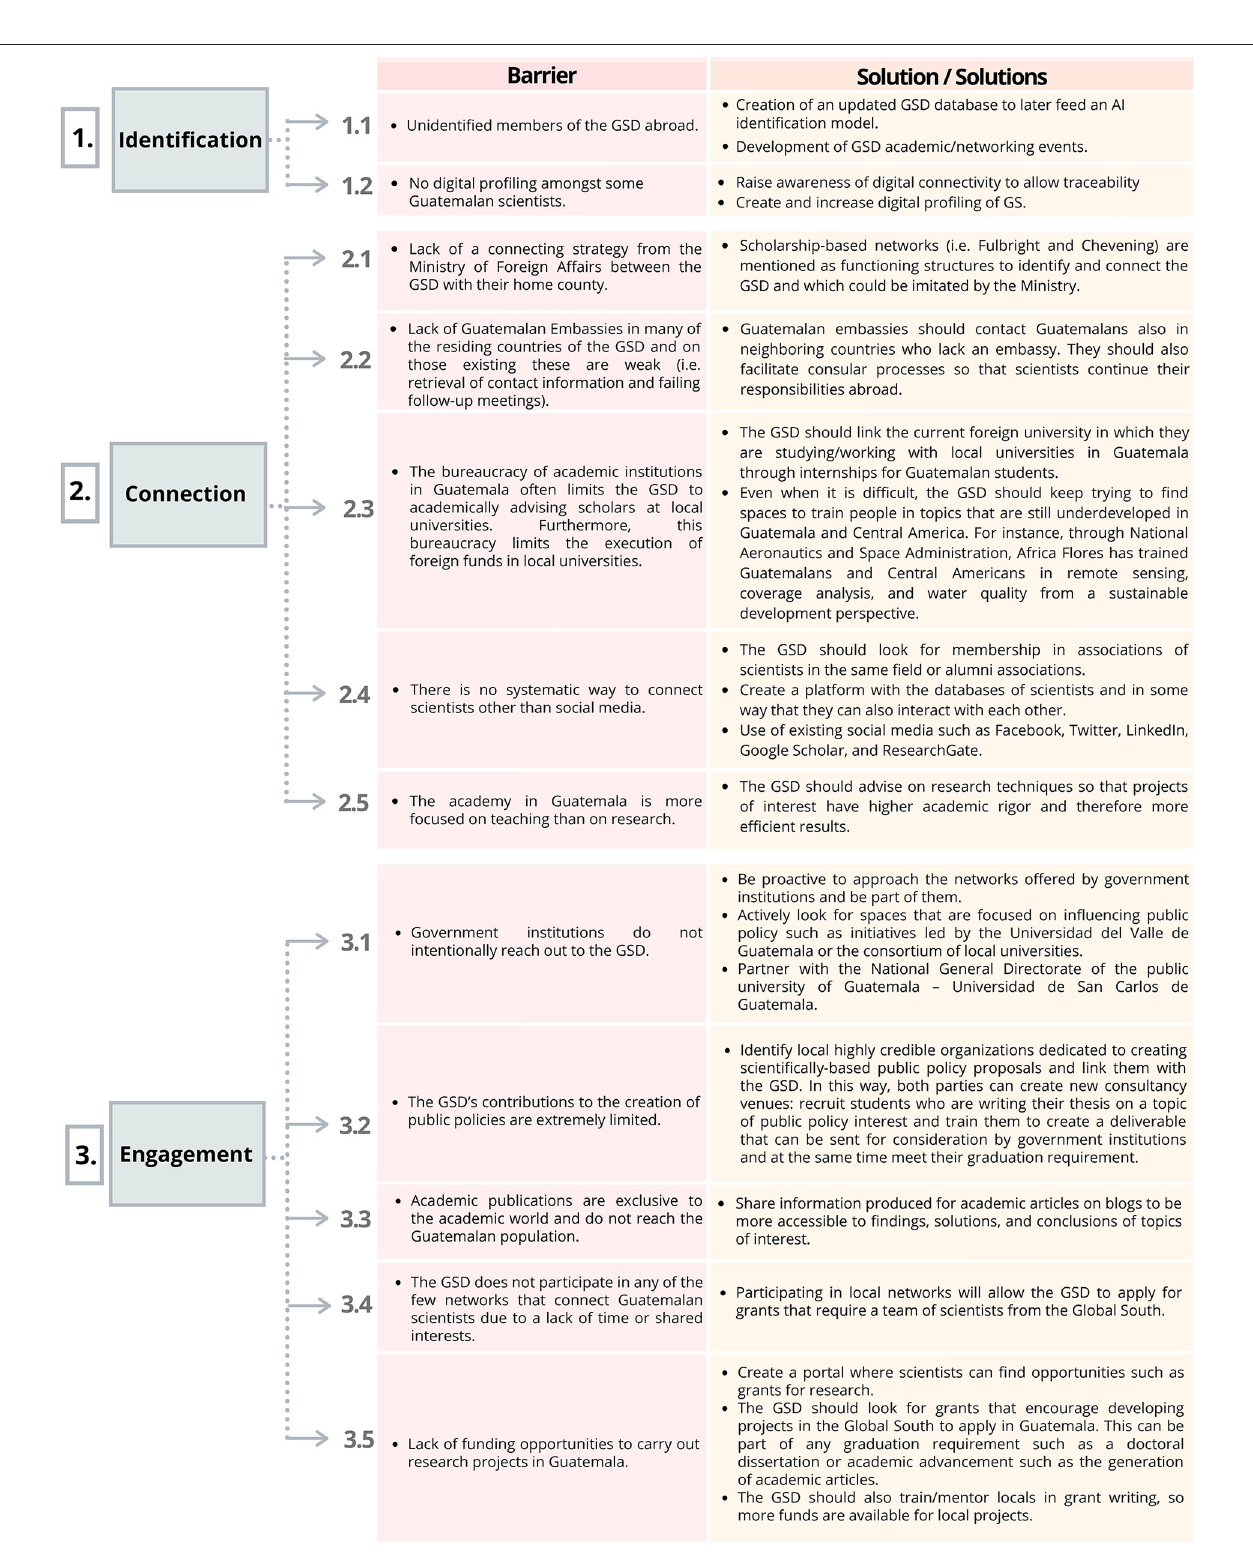
FIGURE 5 | Guatemalan Scientific Diaspora (GSD) - Barriers and solutions identified by members of the GSD (September 2019-February 2020).